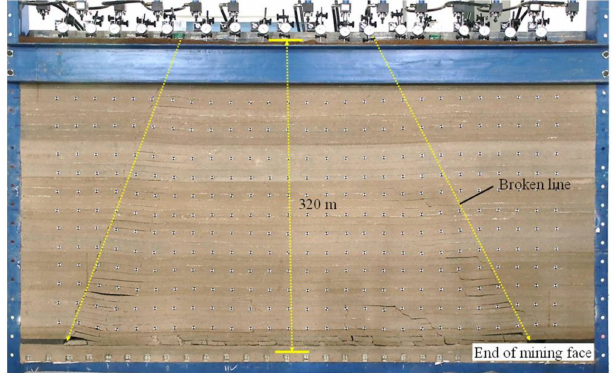
Figure 3. Caving characteristics of the overlying rock after mining of the 8103 working